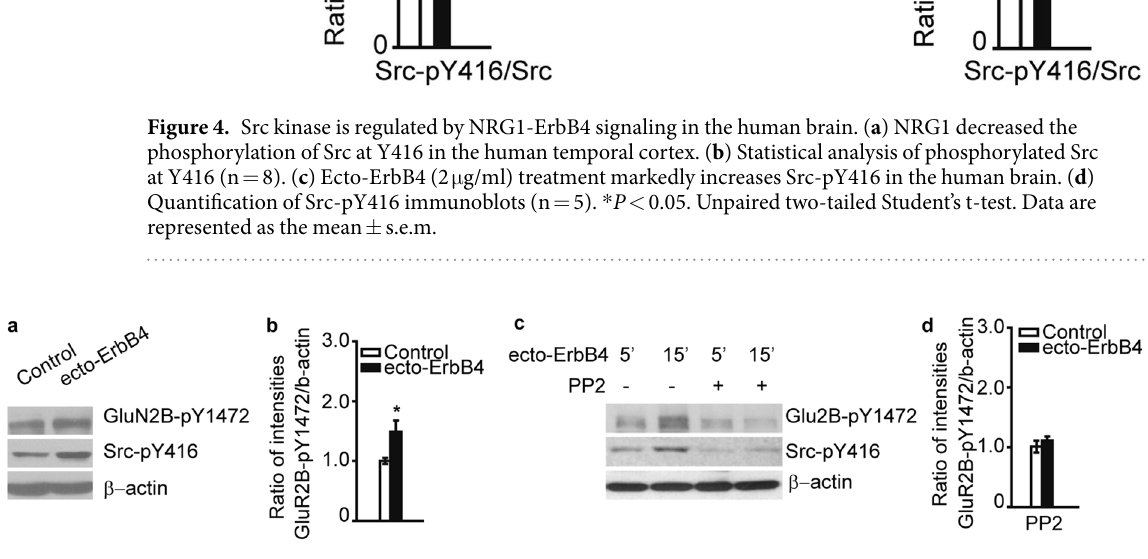
Figure 5. The NRG1-ErbB4 pathway regulates phosphorylation of GluN2B through Src kinase in human tissues. ( a ) Ecto-ErbB4 (2 μ g/ml) treatment simultaneously increased GluN2B-pY1472 and Src-pY416 in human brain slices. ( b ) Quantification of GluN2B-pY1472 immunoblots (n = 5). ( c and d ) Pretreatment with the Src inhibitor PP2 prevents the increase of Glu2B-pY1472 induced by ecto-ErbB4 (n = 3). * P < 0.05. Unpaired two-tailed Student’s t-test. Data are represented as the mean ±